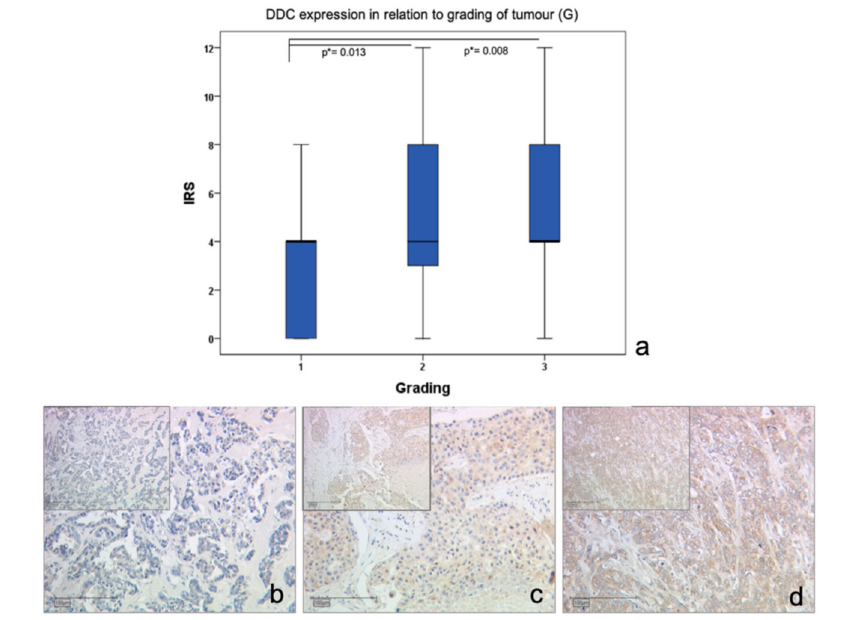
Figure 2. DDC protein expression in breast cancer cells according to tumor grading. ( a ) Boxplot of DDC protein expression in breast cancer according to their grading (* significant p -value), ( b ) DDC staining in breast cancer (grading 1) with IRS = 2, 10 × and 25 × magnification, ( c ) DDC staining in breast cancer (G2) with IRS = 4, 10 × and 25 × magnification, ( d ) DDC staining in breast cancer (G3) with IRS = 6, 10 × and 25 × magnification.